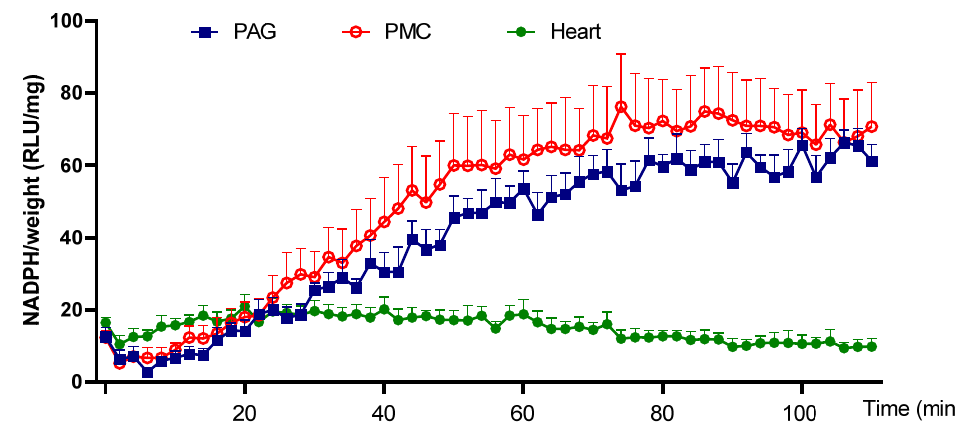
Figure 5. Time course of superoxide generation in PAG, PMC, and cardiac tissue. The plot shows a much more sustained increase of superoxide in brain tissues PAG and PMC than that in cardiac tissue. n = 6.